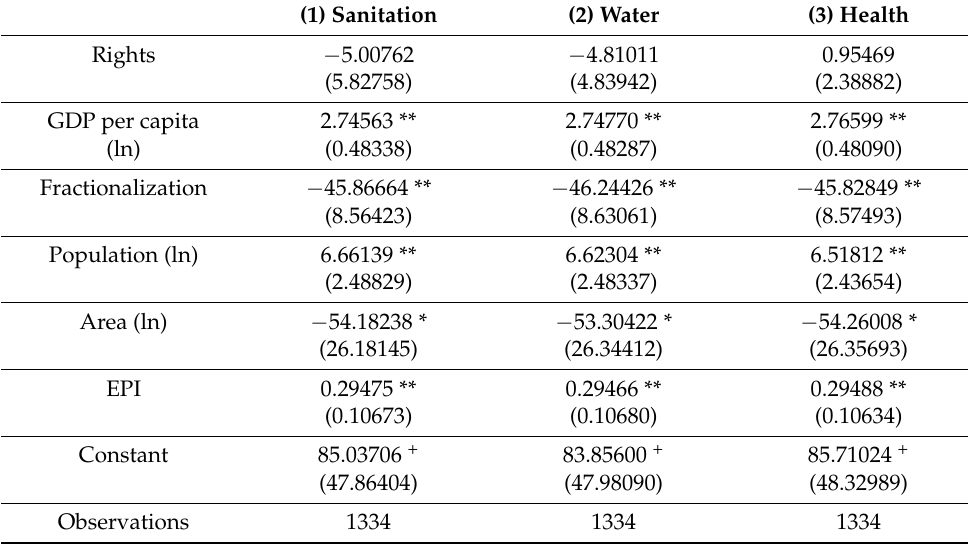
Table 3. Rights & Basic Sanitation Access,